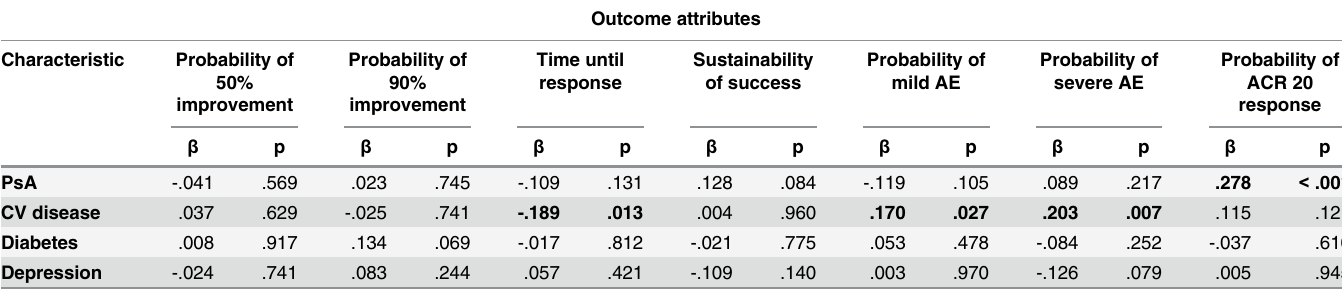
The Relative Importance Score (RIS) was de fi ned as dependent variable. Gender, age, PASI, DLQI, psoriatic arthritis (PsA), cardiovascular (CV) disease, diabetes and depression were used as predictors. β represents the standardized regression coef fi cient. A positive β indicates a higher importance of the attribute compared to the reference group. The reference group for each disease comprised participants who did not suffer from this condition. Signi fi cant fi ndings are highlighted in